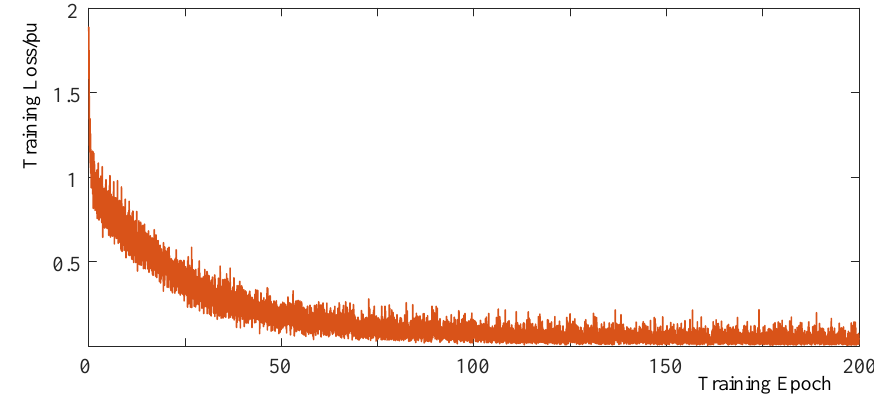
Figure 9. Illustration of the fine-tuning procedure (with 300 training cases generated in